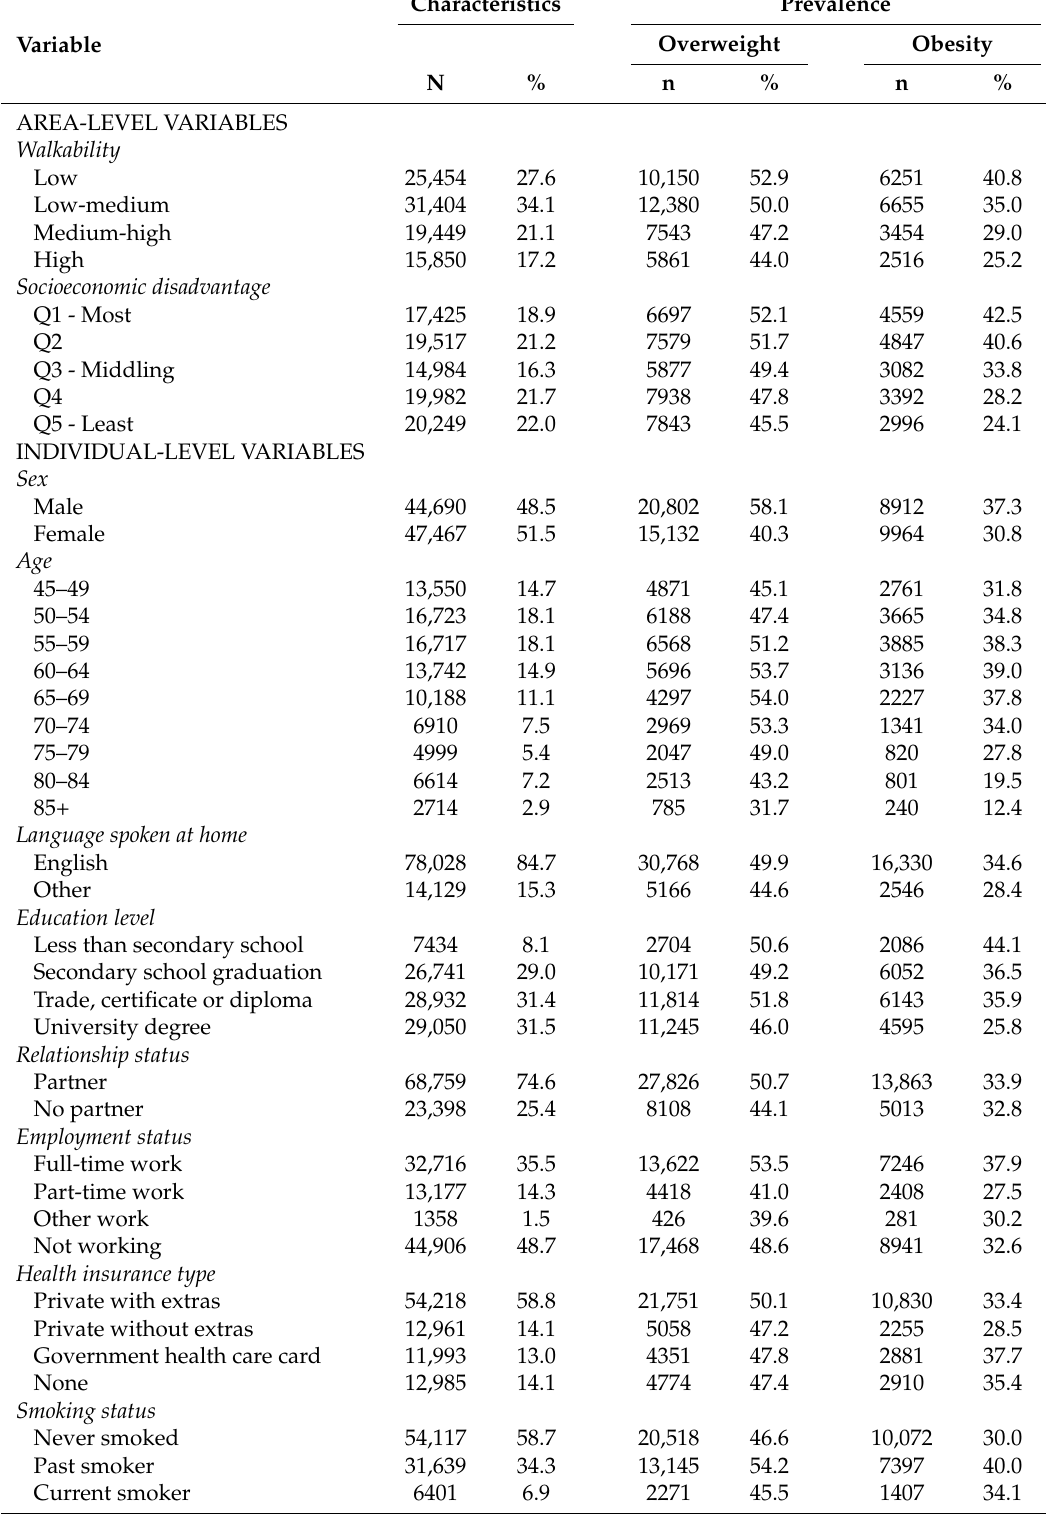
Table 1. Sample characteristics and prevalence of overweight and obesity among study participants.